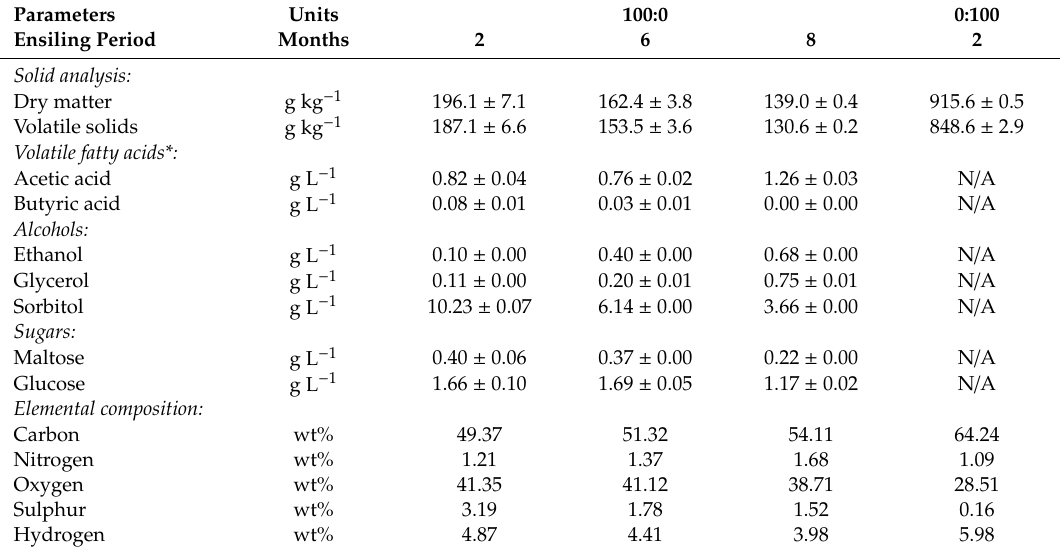
Table 3. Characterization of mono-ensiled substrates of sugar beet root (100:0) and wheat straw (0:100) at di ff erent ensiling